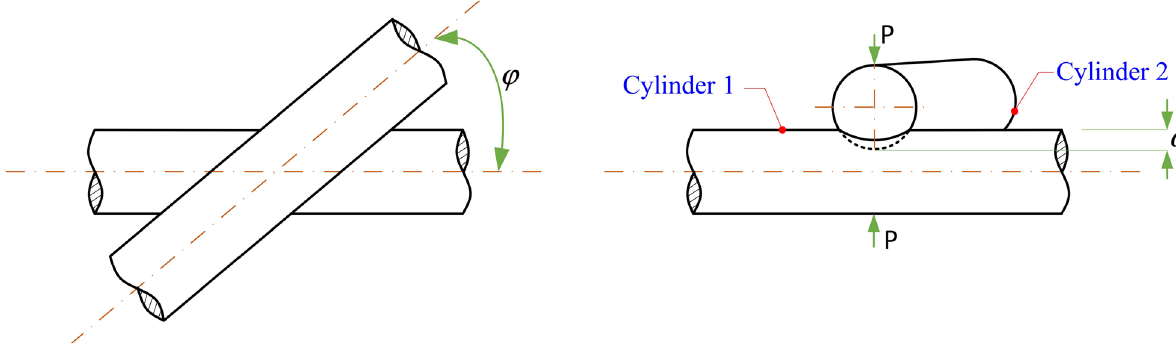
Figure 7. Radial elastic compression between equal-diameter cylinders whose shafts cross at any